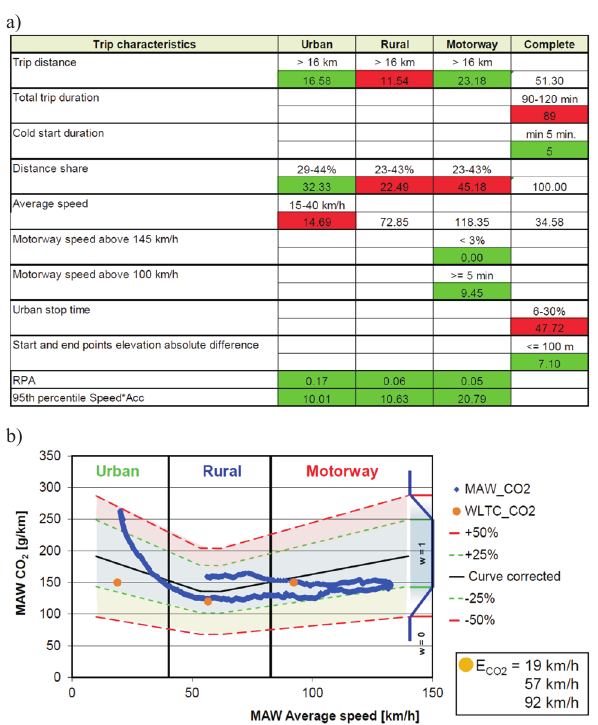
Fig. 9. Characteristics of the test route for a vehicle with a diesel engine (a) and CO characteristic curve 2